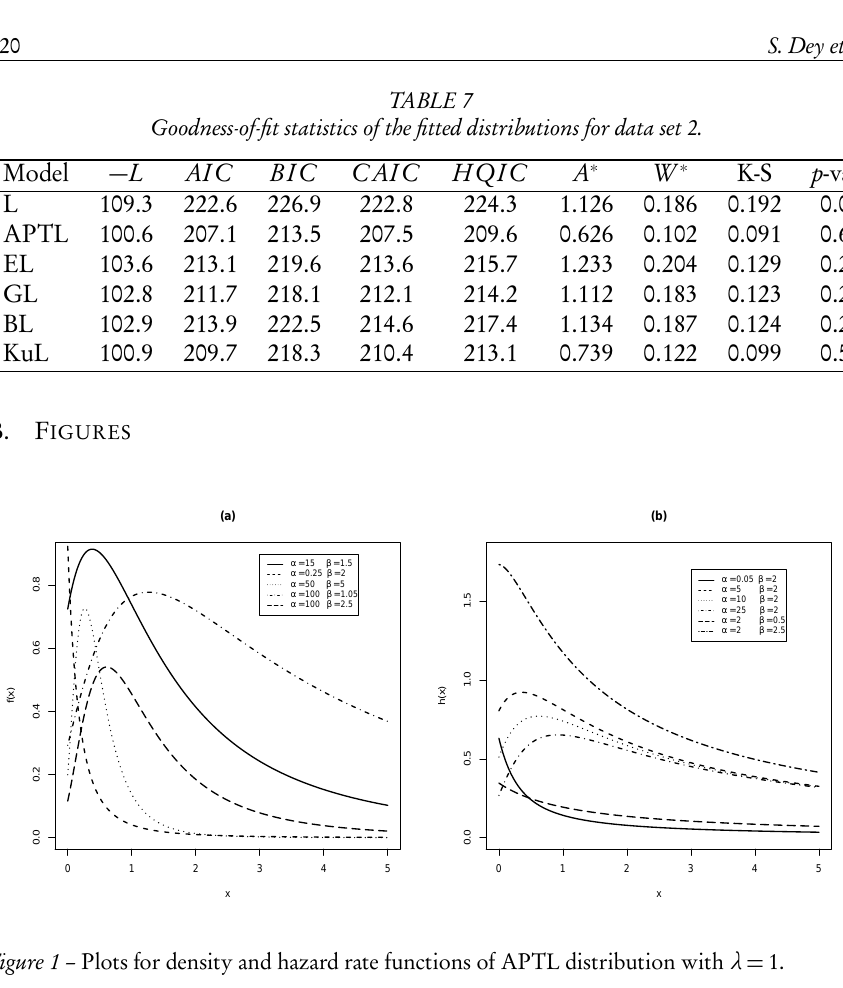
Figure 1 – Plots for density and hazard rate functions of APTL distribution with λ =